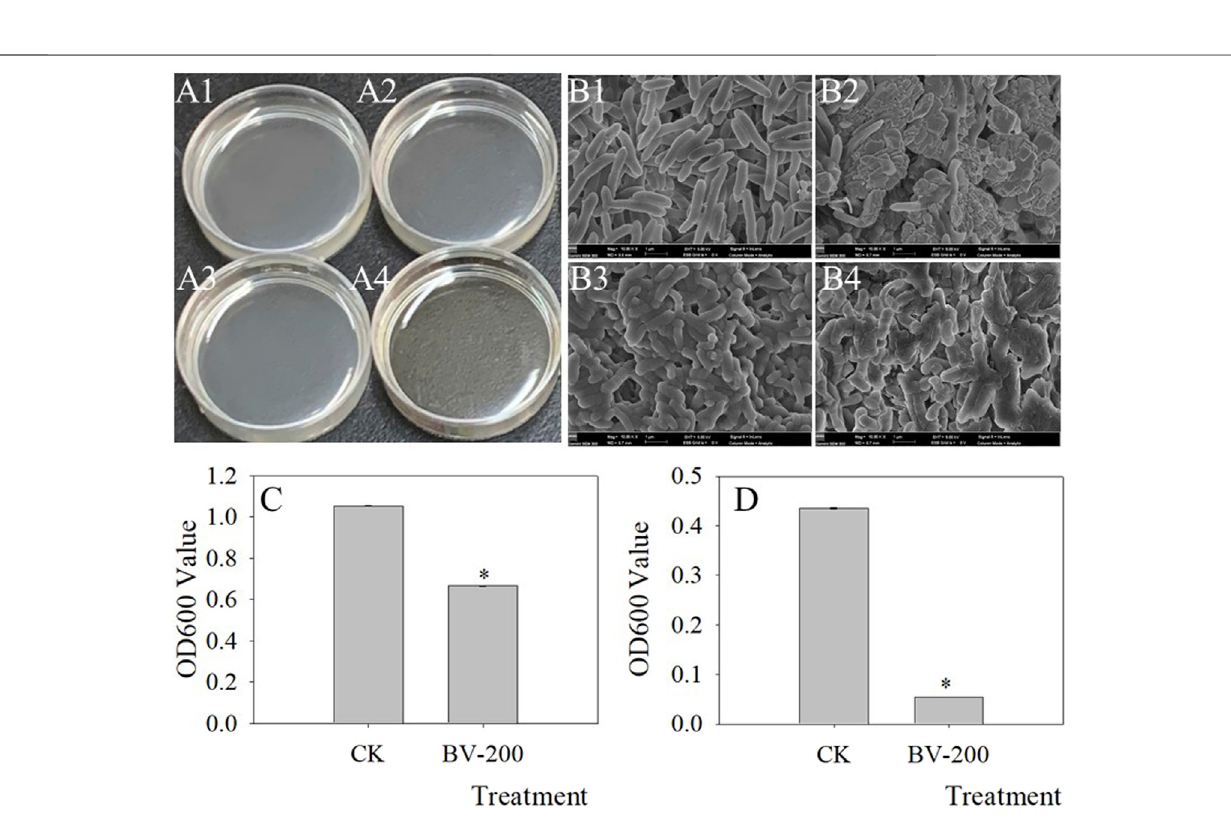
Frontiers in Chemistry |